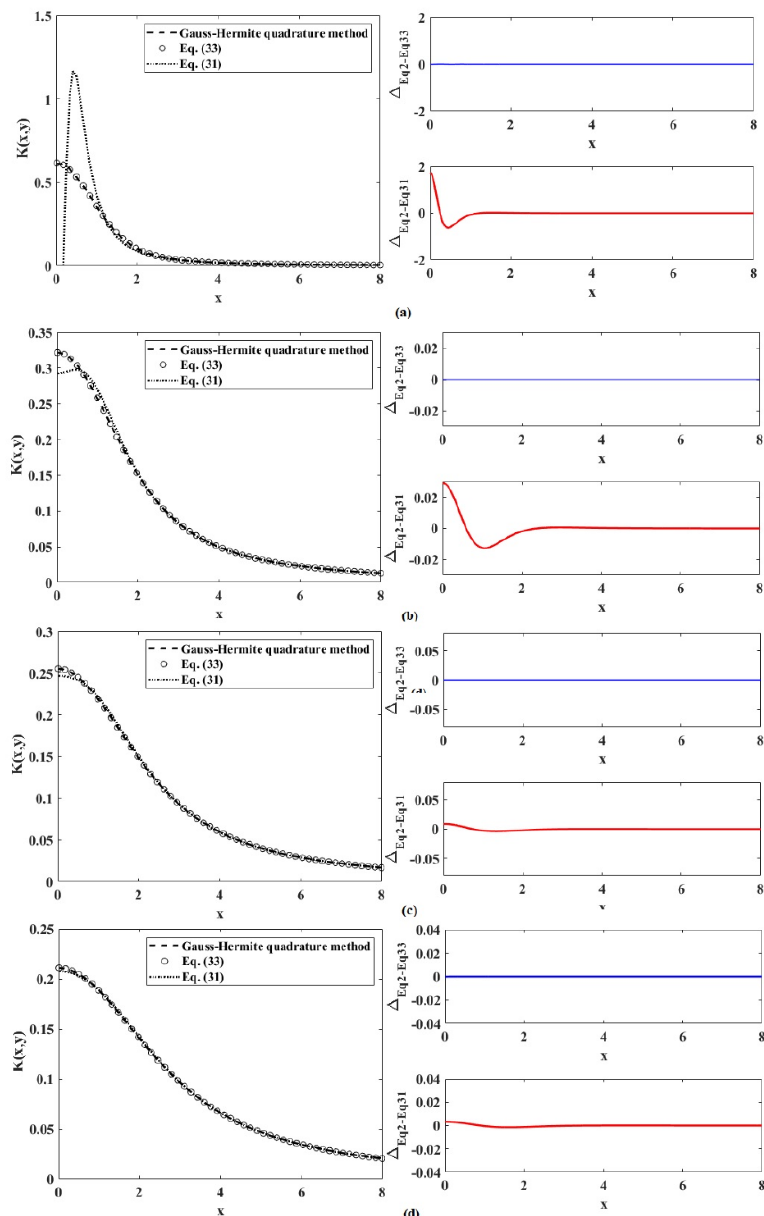
( ) , K x y Figure 4. Illustration of the Voigt function K ( x , y ) in terms of x for different values of y : ( a ) y = 0.5, Figure 4. Illustration of the Voigt function in terms of x for different values of y : ( a ) 0.5 y = , ( b ) 1.5 y = , ( c ) 2 y = , ( d ) 2.5 y = and on the right side, the simulations of the difference ( b ) y = 1.5, ( c ) y = 2, ( d ) y = 2.5 and on the right side, the simulations of the difference between between Equation (33), Equation (2) and Equation (31), Equation (2). Equation (33), Equation (2) and Equation (31), Equation